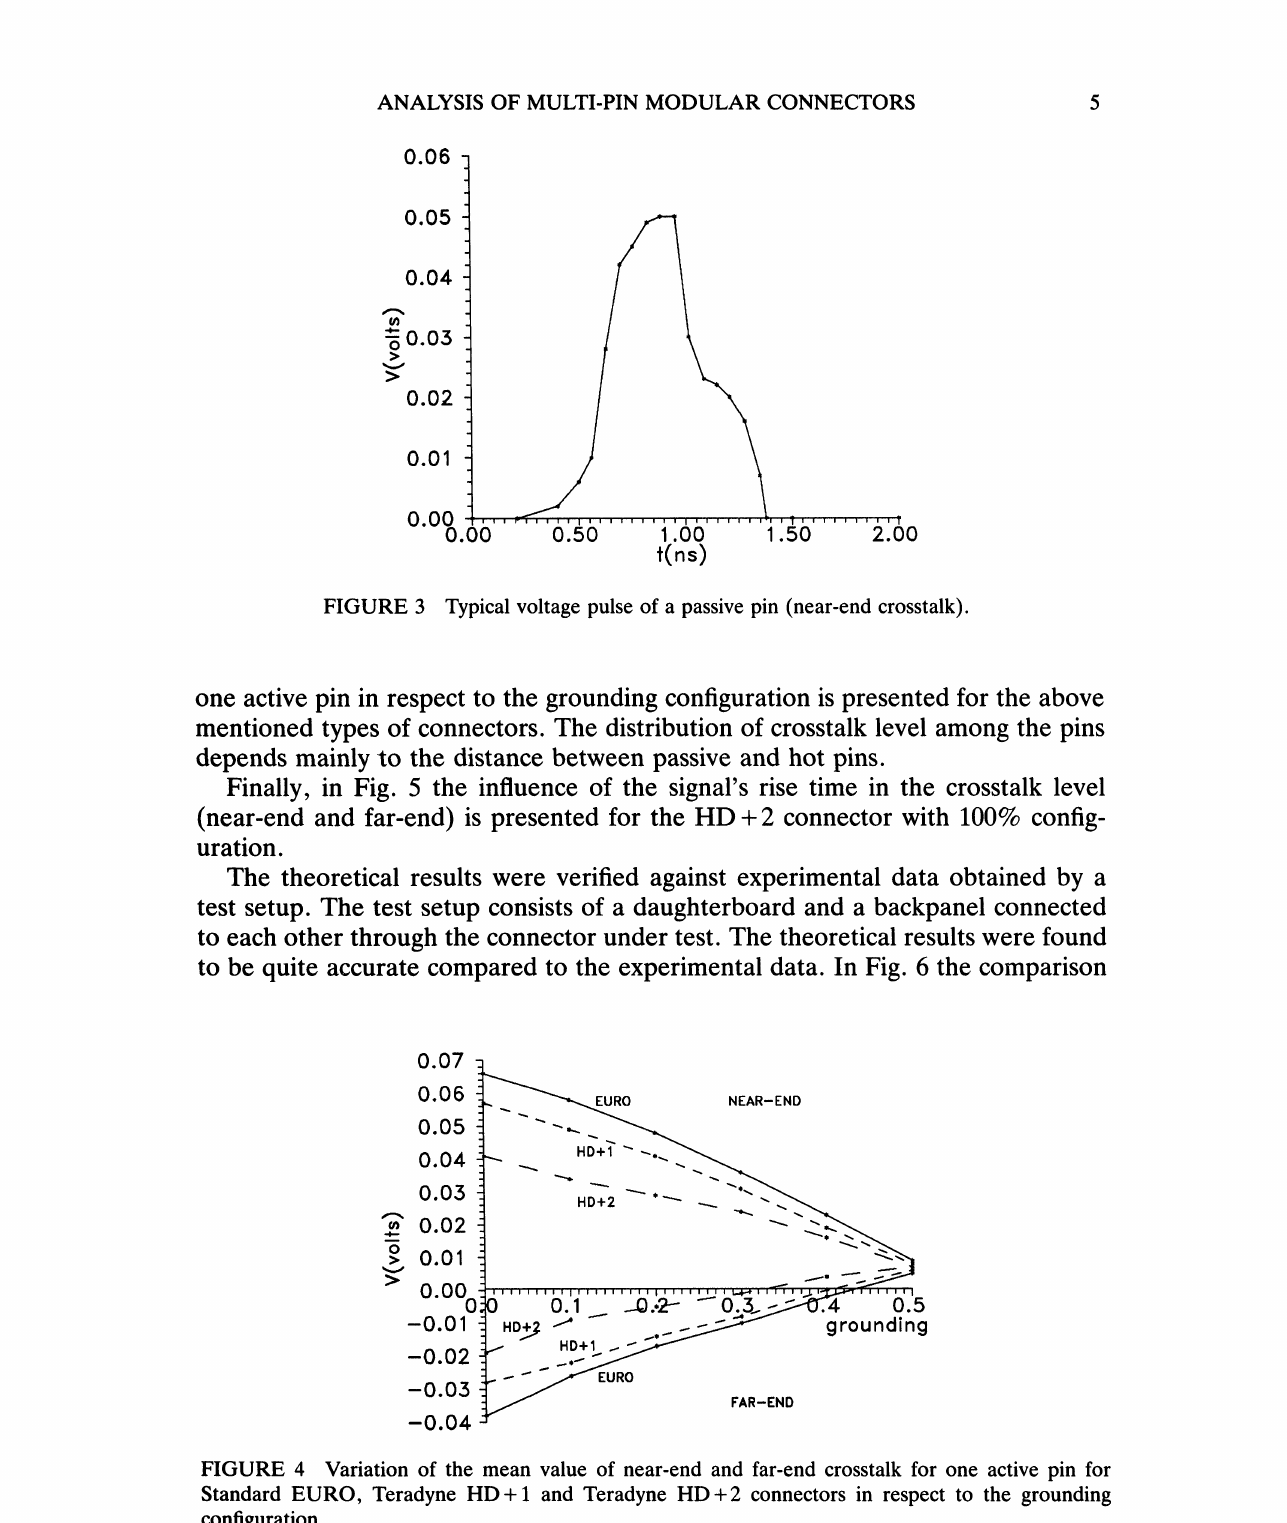
FIGURE 4 Variation of the mean value of near-end and far-end crosstalk for one active pin for Standard EURO, Teradyne HD+ and Teradyne HD+ 2 connectors in respect to the grounding